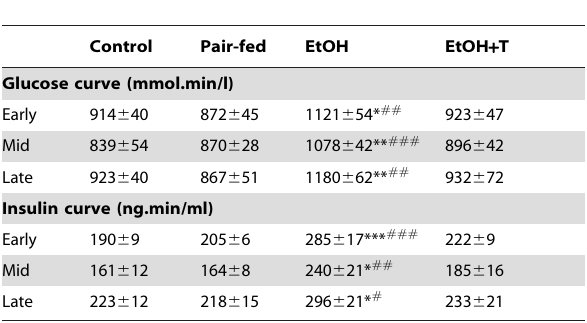
Table 1. Areas under the curve during IPGTT.